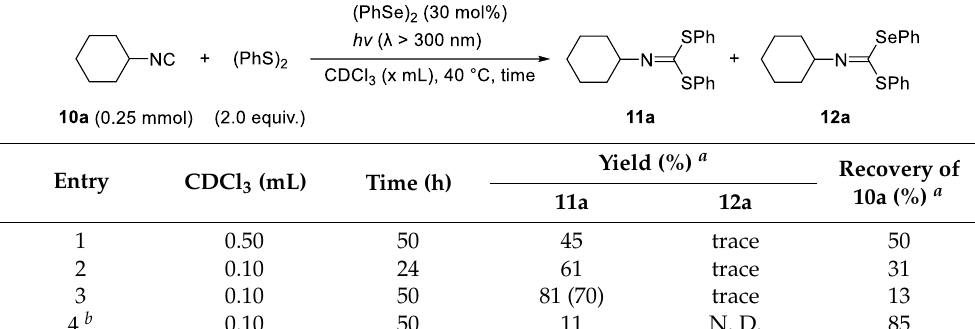
Table 4. Optimization of the reaction conditions for (PhSe) 2 -catalyzed dithiolation of cyclohexyl isocyanide 10a .